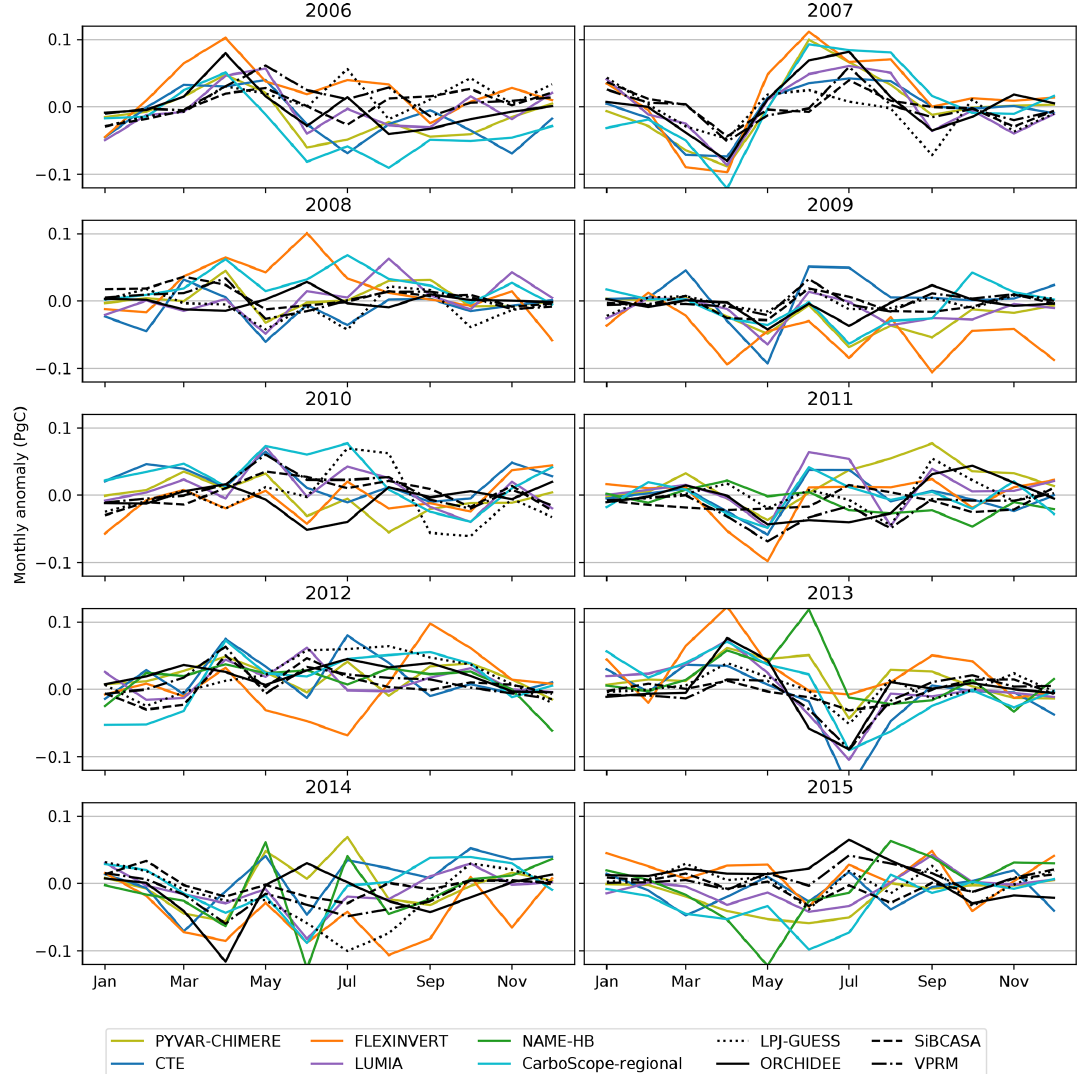
Figure 8. Monthly prior and posterior anomalies of the seasonal cycle, with each simulation compared to its own average seasonal cycle (Fig.